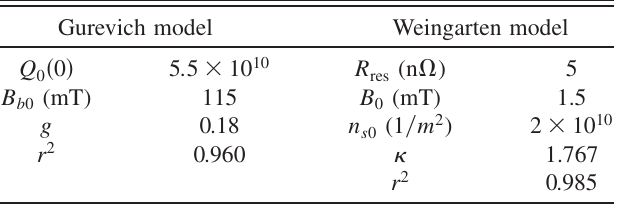
HIGH FIELD Q SLOPE AND THE BAKING EFFECT: . . TABLE I. Fit parameters and fit correlation factor for Gurevich and Weingarten models applied to the data shown in ¼ 190 mT were used in Fig. 1. Values of (cid:4) ¼ 36 nm and B c Eq. (2).